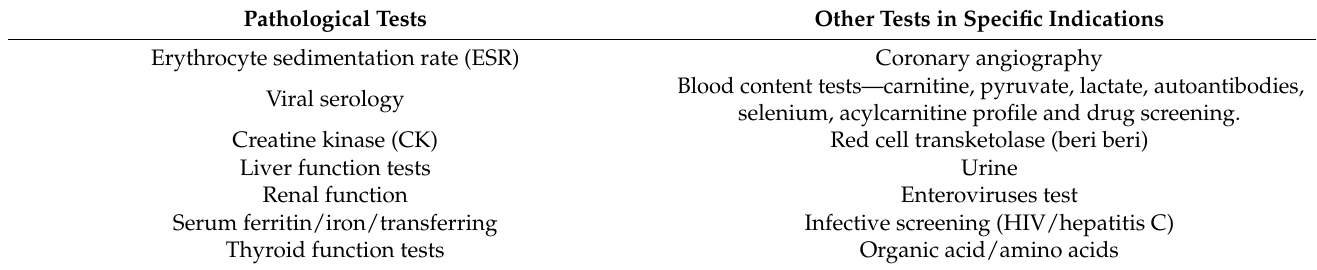
Table 4. Pathological tests for DCM diagnosis